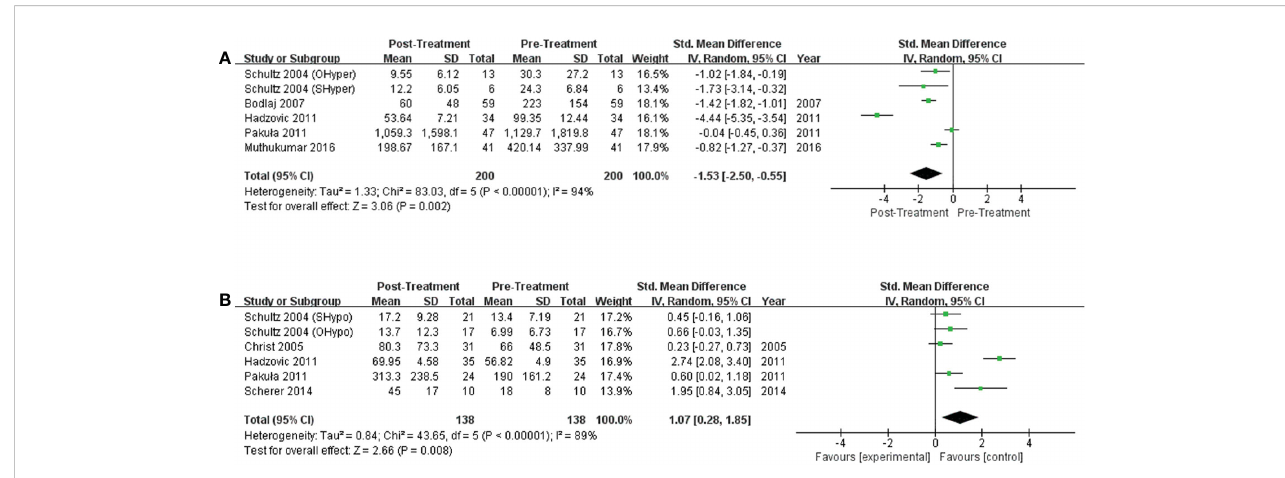
FIGURE 4 Forest plot of the NT-proBNP levels in subjects with (A) hyperthyroidism from pre- to post-treatment; (B) hypothyroidism from pre- to